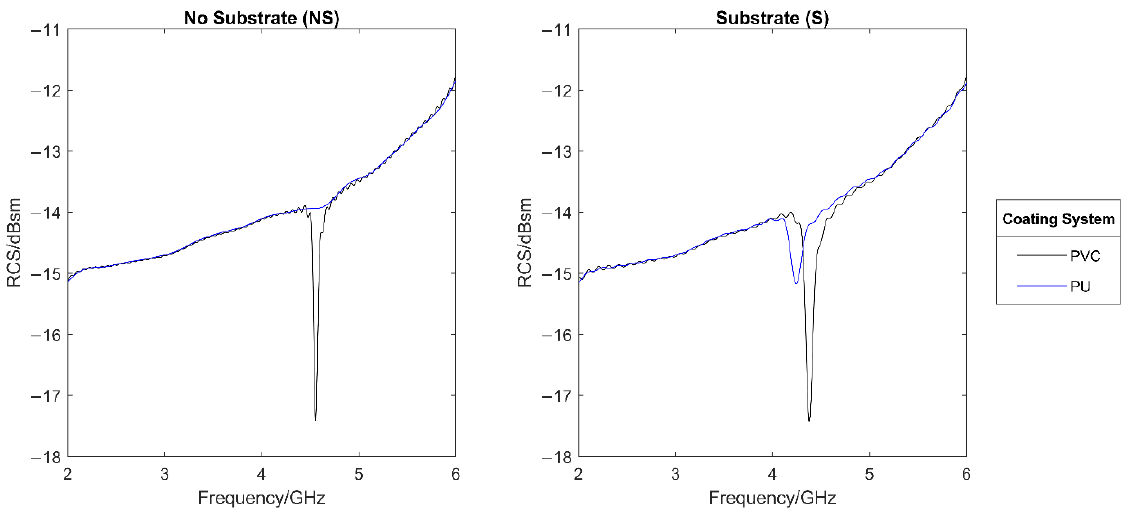
Figure 10. Simulated RCS response of sensors mounted directly on coated system (NS, left ) and sensors mounted on an additional substrate (S, right ).